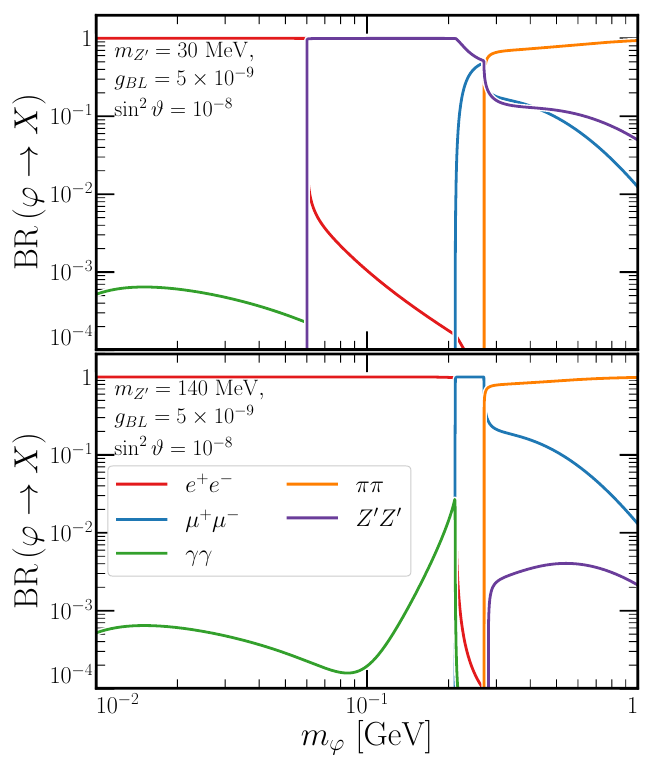
Figure 2 . BRs of the scalar ϕ in the U(1) B − L model into ee , µµ , γγ , ππ (including both π 0 π 0 and π + π − ) and Z 0 Z 0 , as a function of the scalar mass. In both panels, we take g BL = 5 × 10 − 9 and sin 2 ϑ = 10 − 8 . The top (bottom) panel assumes m = 30 MeV ( 140 MeV). Z 0